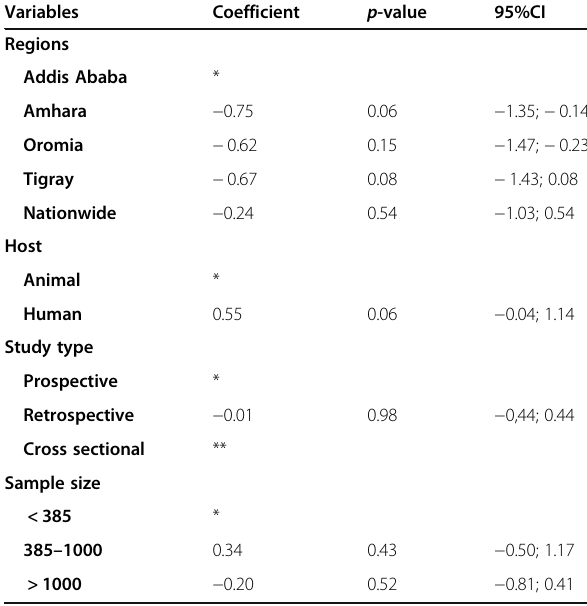
Table 3 Multivariable meta-regression